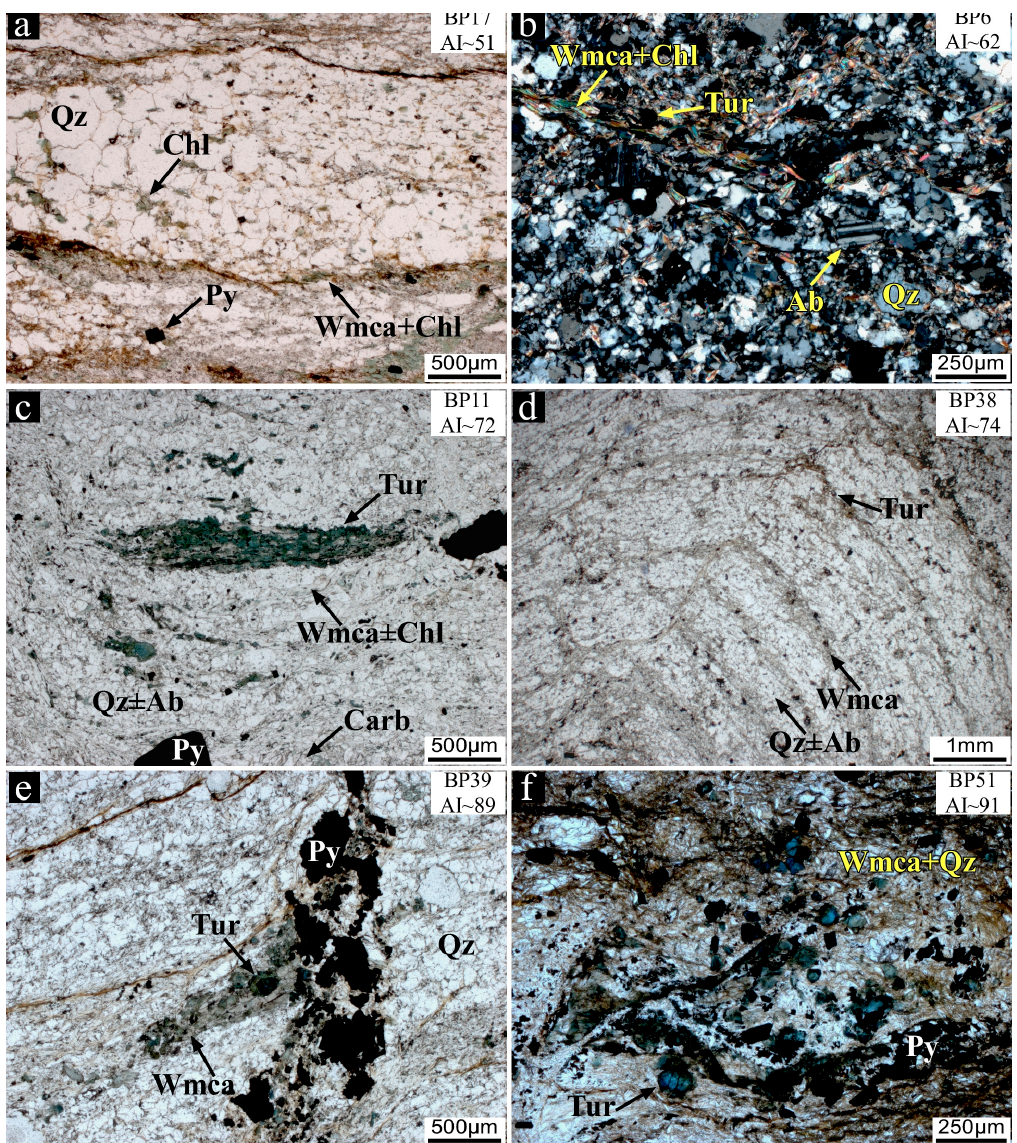
Figure 4. Petrographic features of the “Filladi Inferiori” from Sant’Anna tectonic window. ( a ) Alternance of granoblastic and lepidoblastic levels in a phyllitic quartzite. ( b ) Albite crystals in a granoblastic level. Note the occurrence of small clastic tourmaline crystals. ( c ) Tourmaline pod aligned along the main foliation with pyrite crystals. ( d ) Folded levels with granoblastic and lepidoblastic texture. ( e , f ) Tourmaline porphyroclasts associated with pyrite in a white mica + quartz matrix. Mineral abbreviation: Ab, albite; Carb, carbonates; Chl, chlorite; Py, pyrite; Qz, quartz; Tur, tourmaline; Wmca, white mica.